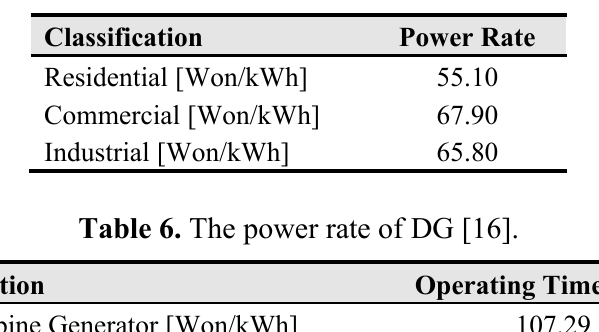
Table 5. The power rate of KEPCO in 2008 [16].